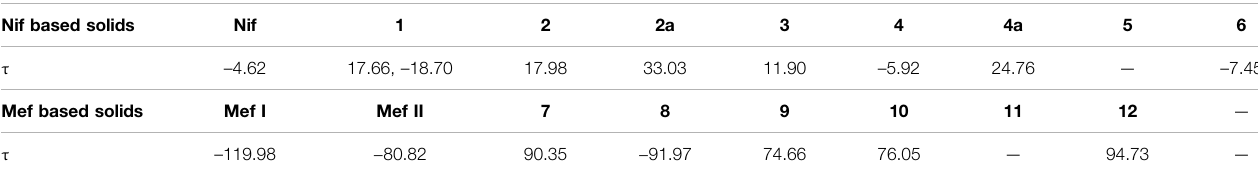
TABLE 4 | Torsional angles of Nif and Mef in the salt/cocrystal form and in the free state. Nif based